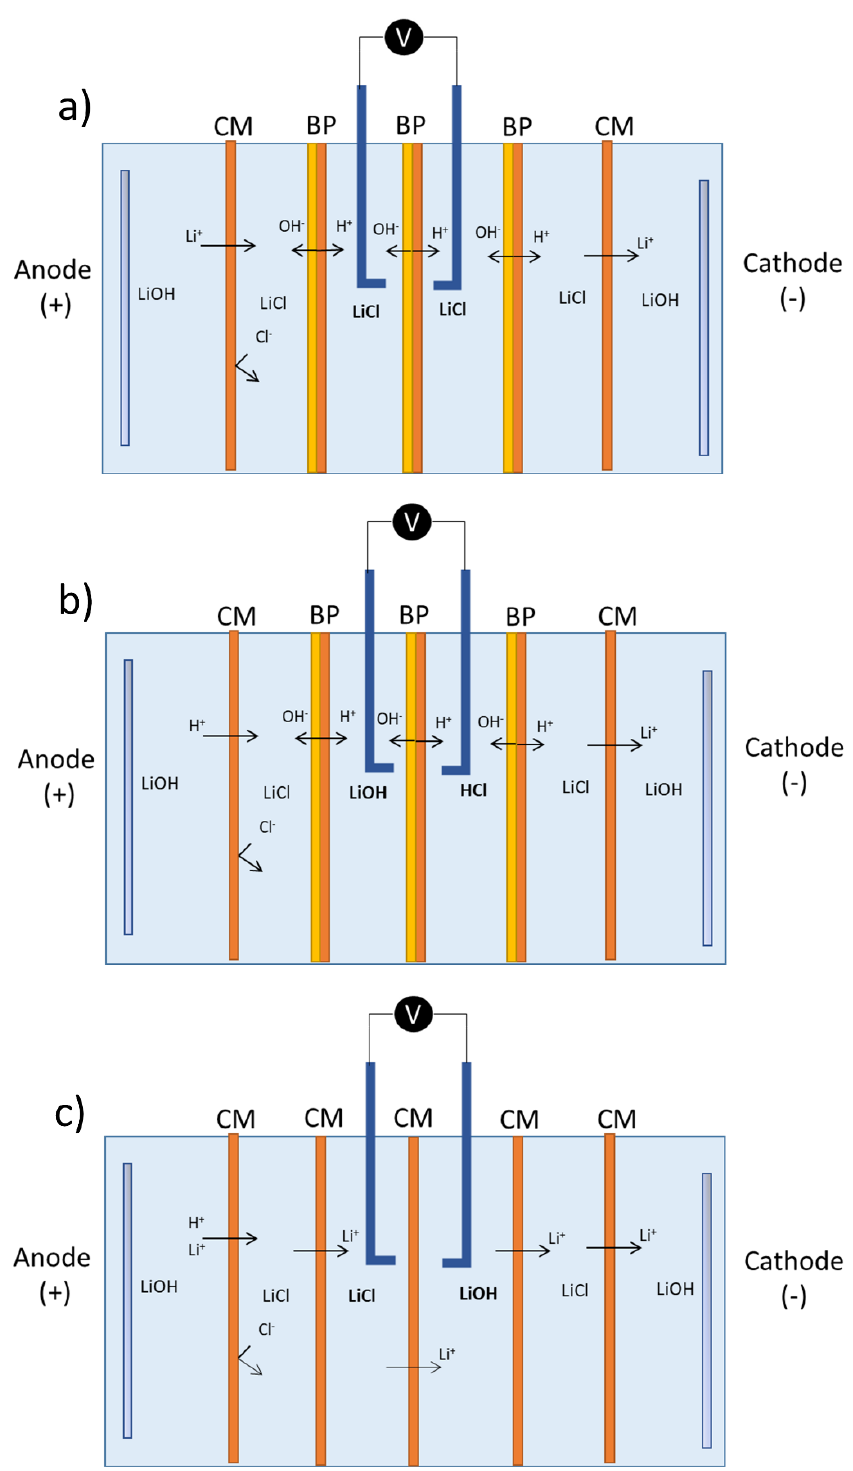
Figure 2. LSV tests’ cell configuration. ( a ) Limiting current density measurement as related to Figure 2. LSV tests ’ cell configuration. ( a ) Limiting current density measurement as related to salt salt leakage in bipolar membranes (BP). ( b ) Bipolar membranes’ apparent electrical resistance mea- leakage in bipolar membranes (BP). ( b ) Bipolar membrane s’ apparent electrical resistance meas- surements as related to operating conditions. ( c ) Cation-exchange membranes’ (CM) concentration urements as related to operating conditions. ( c ) Cation-exchange membranes ’ (CM) concentration polarization determination in the range under polarization determination in the range under study.